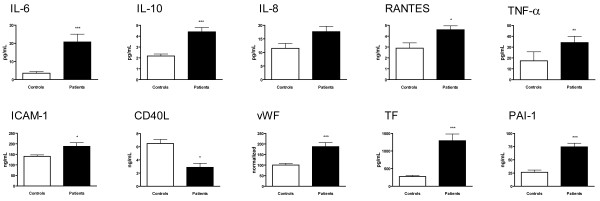
Plasma and serum levels of IL-6, IL-10, IL-8, RANTES, TNF-α, ICAM-1, soluble CD40L, vWF, tissue factor (TF), and PAI-1 in patients with CNPA (n = 10, black columns) and healthy controls (n = 19, white columns). Data are mean ± SEM. P- values are adjusted for the use of voriconazole. *p < 0.05, **p < 0.01 and ***p < 0.001 versus controls.